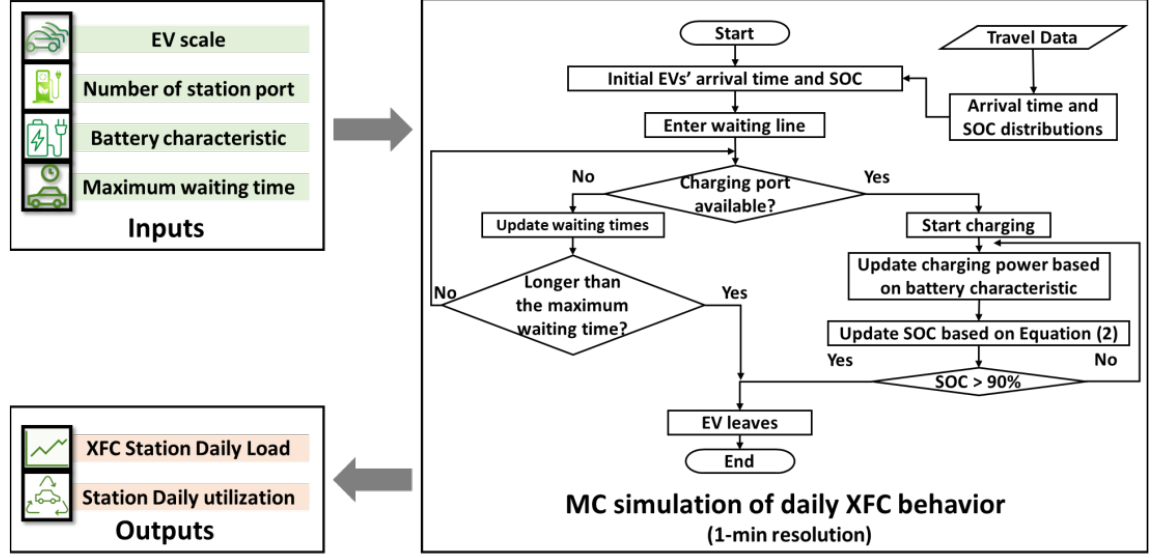
Figure 1. EV Charging demand estimation using Monte Carlo simulation.